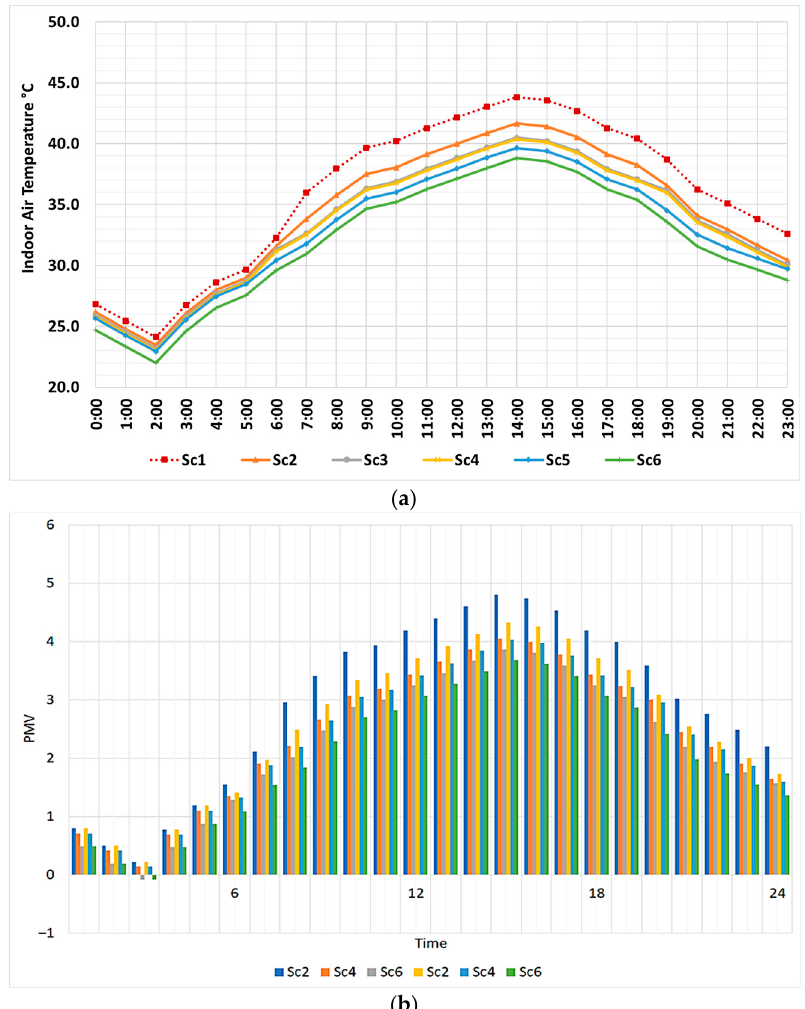
Figure 6. The thermal condition in the investigated building. ( a ) Indoor air temperature using varied polycarbonate windows; ( b ) thermal comfort using PMV index.